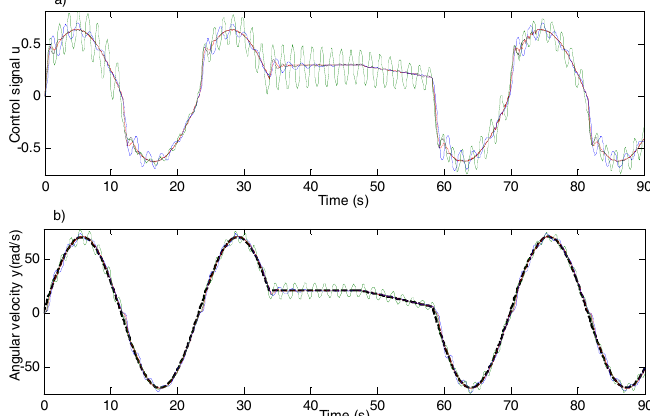
Figure 5. Experimental results of case study (1): control signal u of CS with VRFT-iP (black), CS with iP (red), CS with VRFT-I (green), and CS with I (blue) controllers in ( a ); reference trajectory y d (solid black dashed), controlled output y of CS with VRFT-iP (black), CS with iP (red), CS with VRFT-I (green), and CS with I (blue) controllers in ( b ).